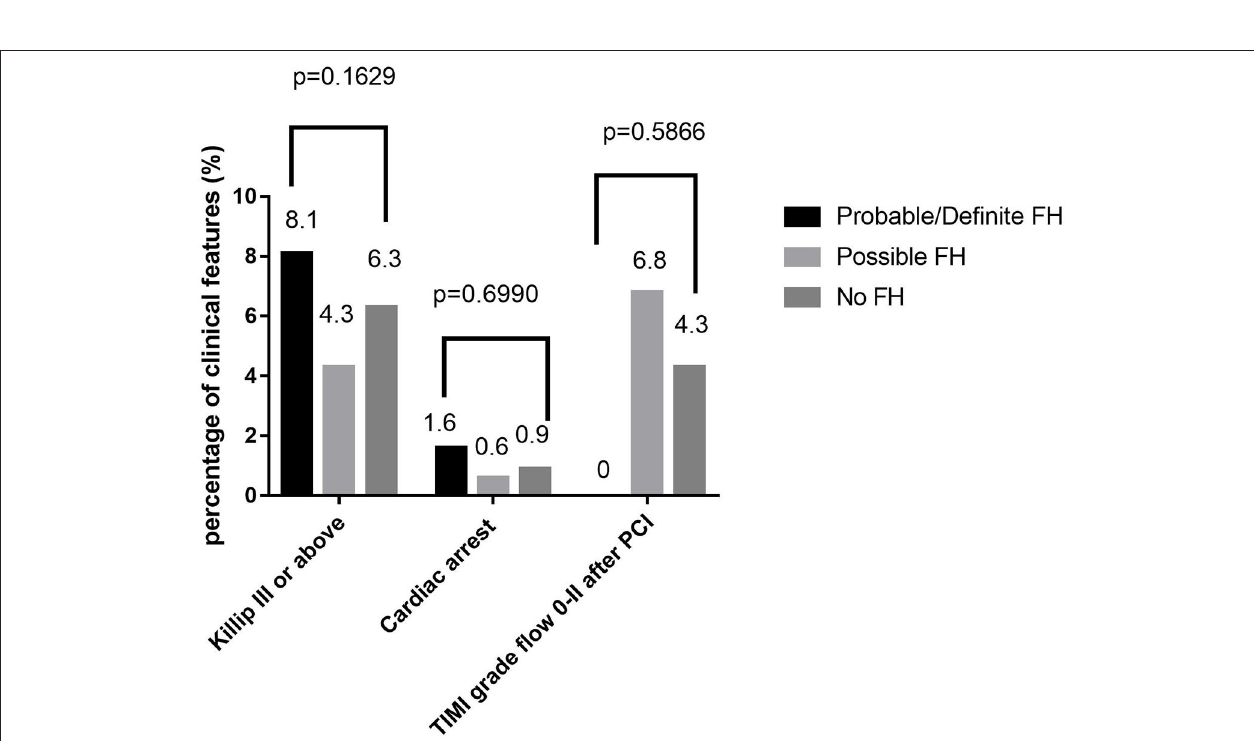
FIGURE 4 | Comparison about severe clinical manifestations among probable/definite HeFH, possible HeFH, and non-HeFH groups.